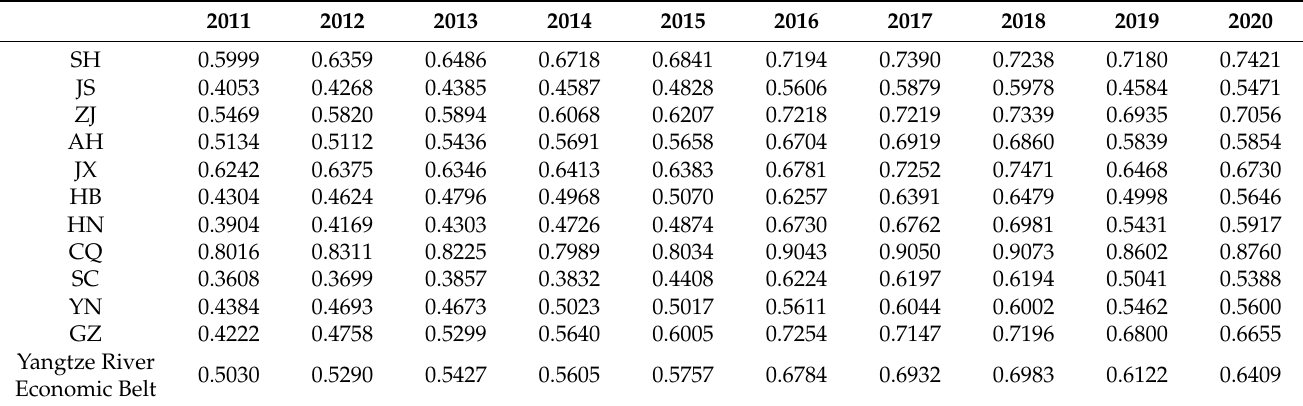
Table 5. Eco-environmental quality index.